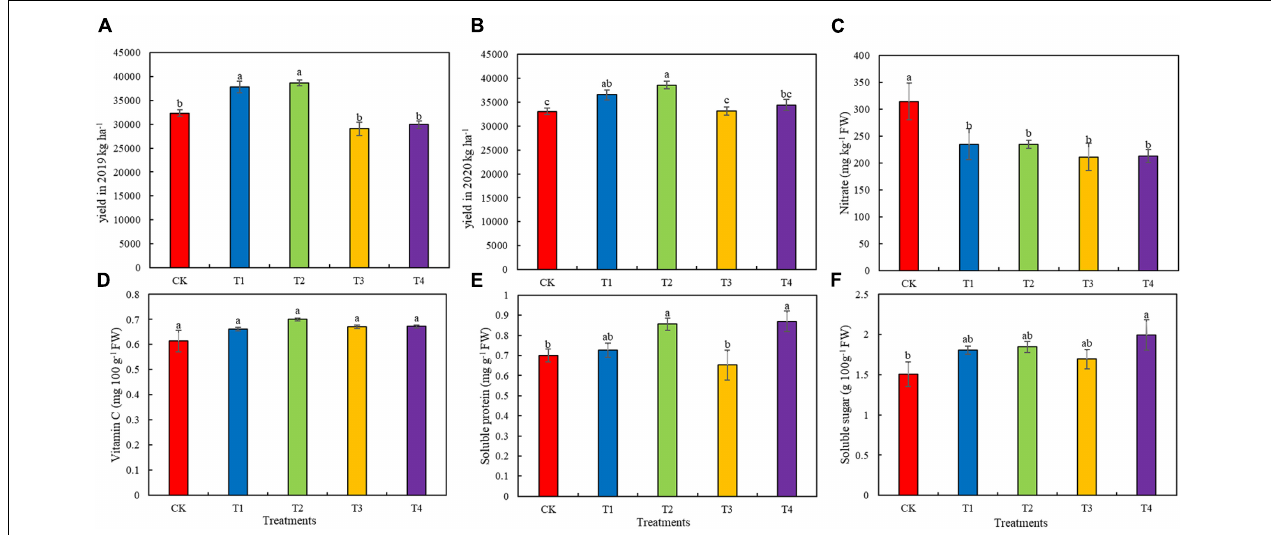
FIGURE 4 | Yield and quality parameters of lettuce grown in soils with different fertilization treatments. (A) Yield in 2019. (B) Yield in 2020. (C) Nitrate content of lettuce. (D) Vitamin C content of lettuce. (E) Soluble protein content of lettuce. (F) Soluble sugar content of lettuce. Values presented are the means ± SE ( n ≥ 3). Vertical bars indicate the SE of the means. Different lowercase letters indicate significant differences among treatments at the same timepoint (Duncan’ s test, p < 0.05). CK, T1, T2, T3, and T4 are as defined in the Figure 1 legend.